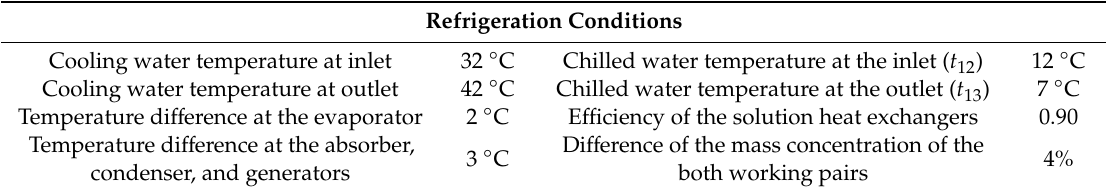
Table 2. Refrigeration conditions of the double-e ff ect absorption cycle.